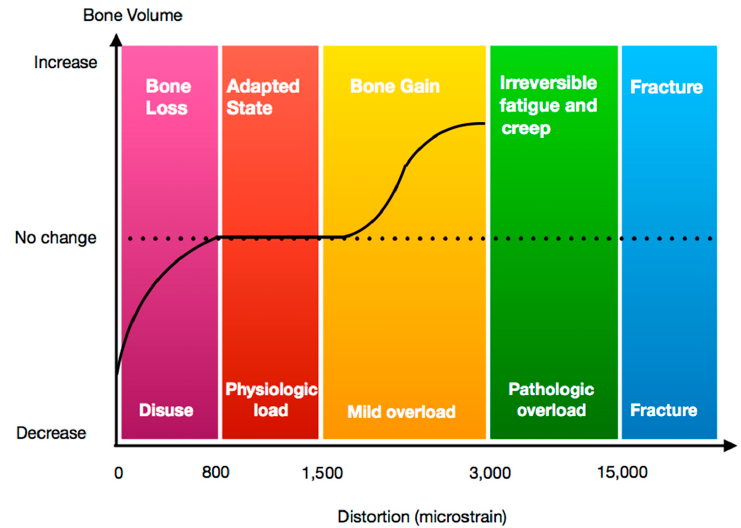
Figure 1. Diagram showing clinical effect on bone relative to strain level applied.